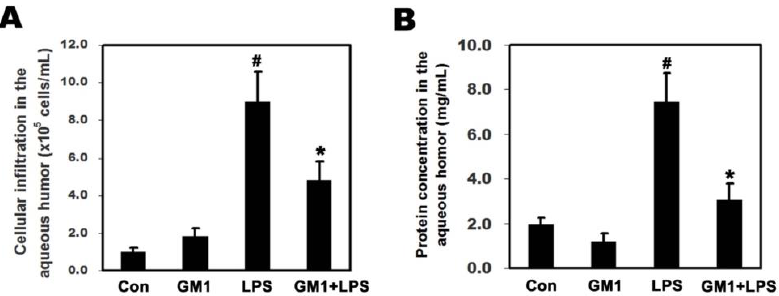
Figure 2. Effects of GM1 on cellular infiltration and protein concentration in the AqH of rats with EIU. Rats were pretreated with GM1 and then treated with or without LPS for another 24 h. The AqH was collected from each group, cells were counted, and the protein concentration was measured by a blinded observer. GM1 significantly decreased cellular infiltration ( A ) and protein concentration ( B ) in the AqH of EIU rats. The data are presented as the mean ± SD. # p < 0.05 compared with the control group; * p < 0.05 compared with the LPS-treated group. n = 6 rats per group. AqH: aqueous humor.